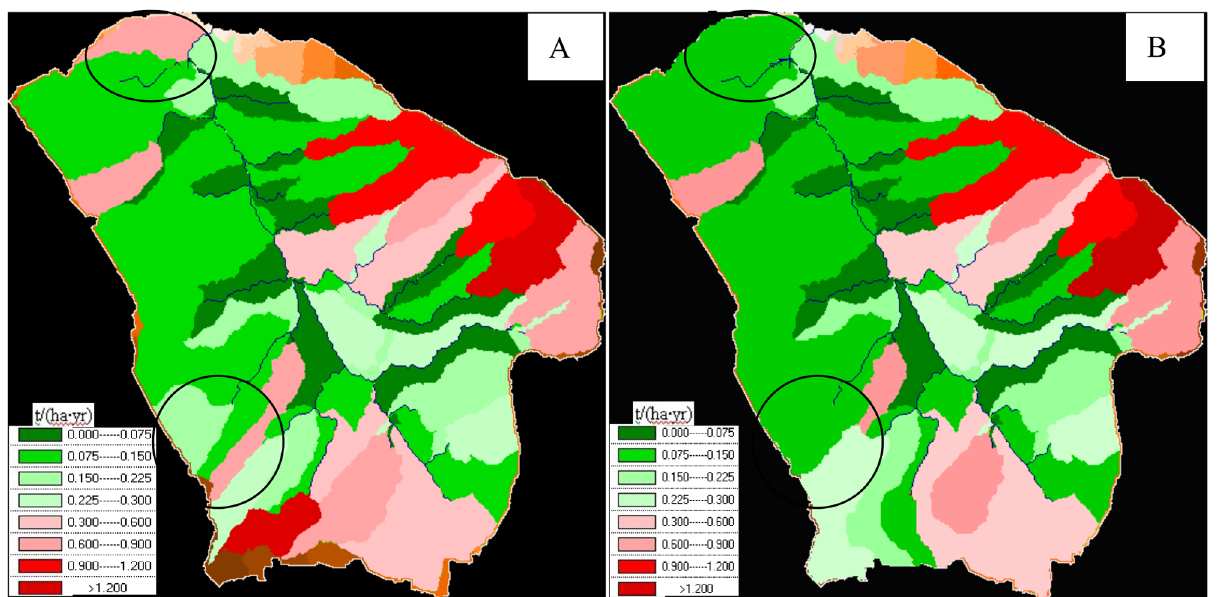
Fig 3. Soil erosion distribution map in small watershed.